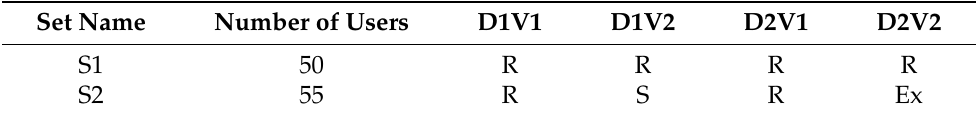
Table 1. Selected database visit distribution, where the number after D represents the day, and the one after V, the visit in that day. The different scenarios are represented as R for resting, sitting down; S for resting, standing up and Ex for after exercise (average of 130 bpm). Each subset is named S1 or S2 for easier